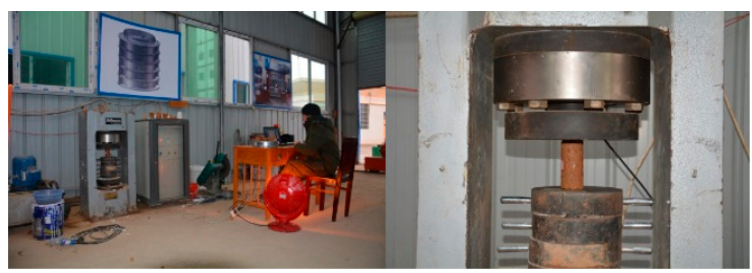
Figure 15. Compression test.